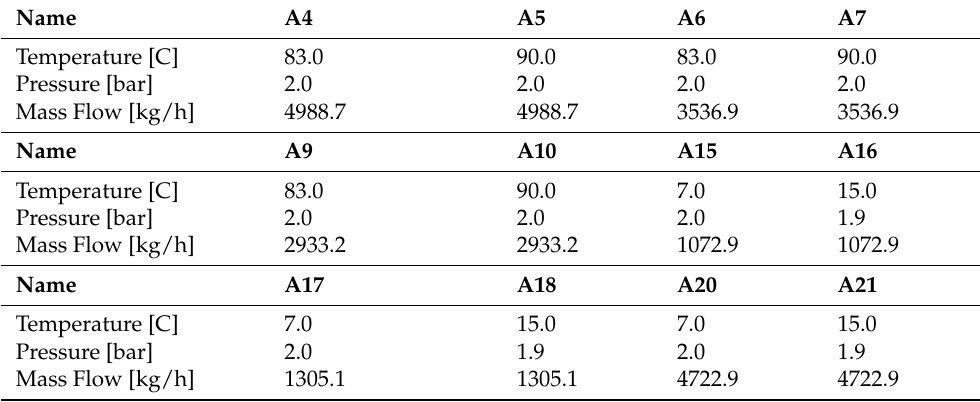
Table A14. States of the water flows in